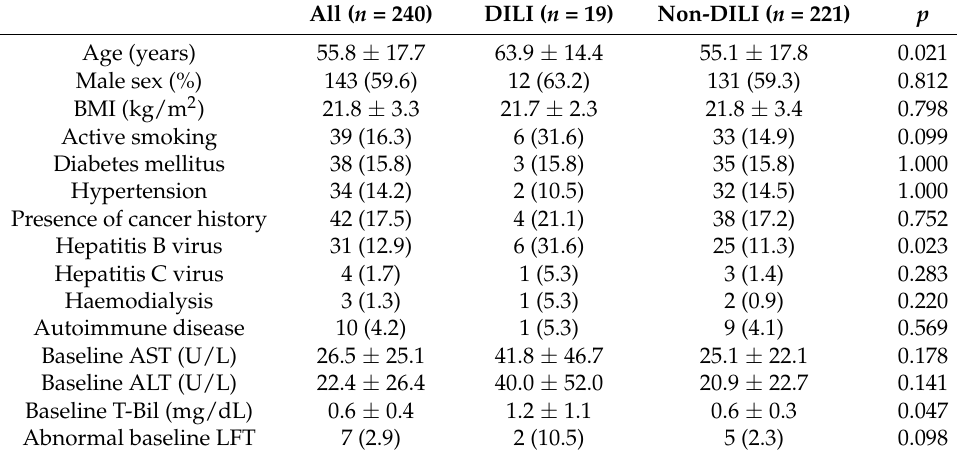
Table 1. Characteristics of patient demographics.